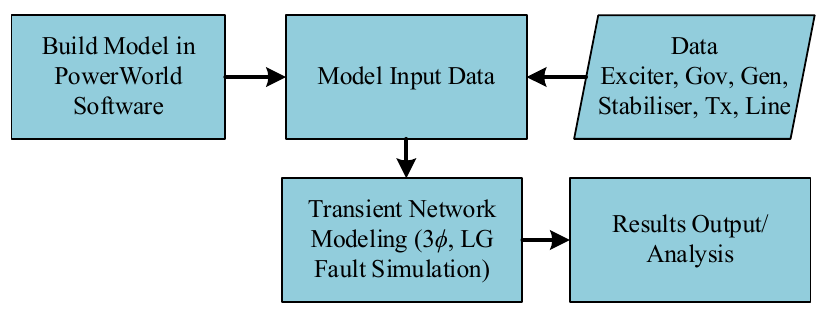
Figure 1. Methodology flow chart.